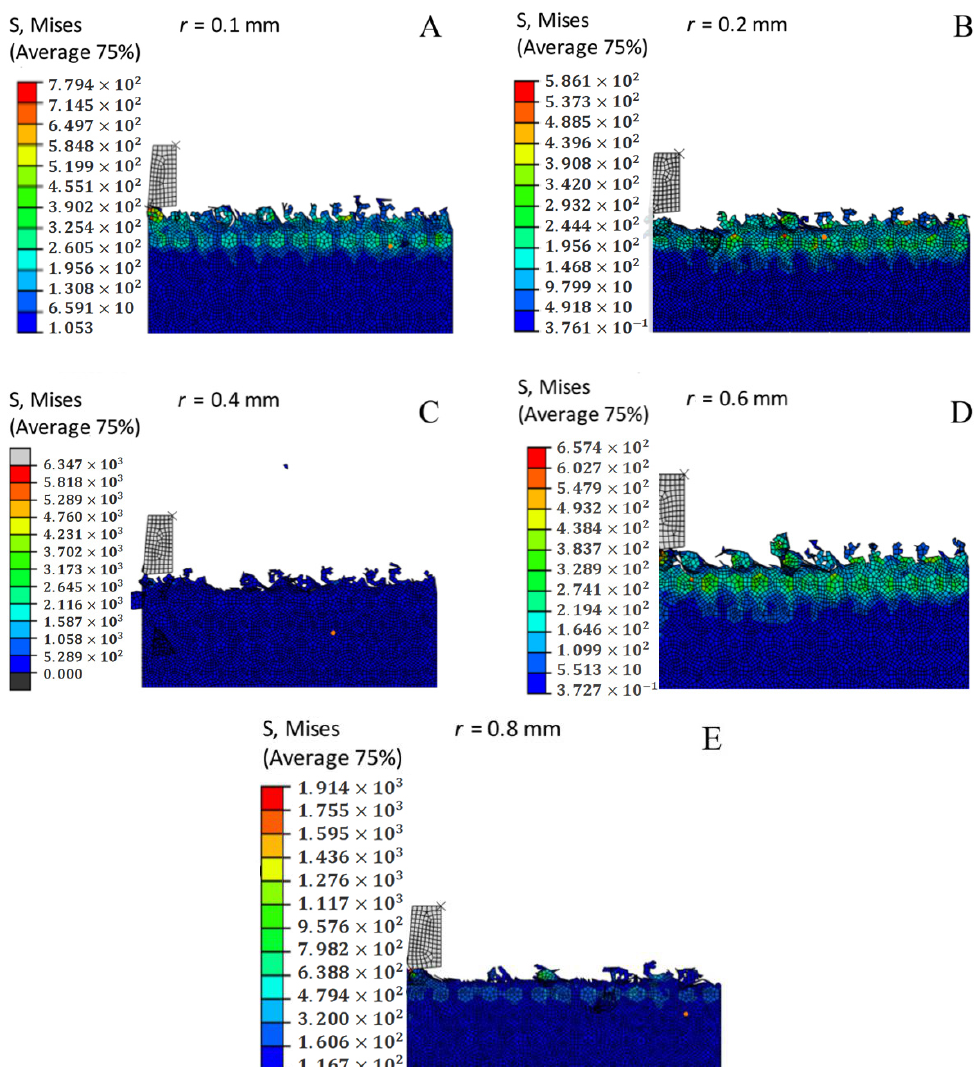
Figure 15. Chip morphology in milling with different corner radii. ( A ) r = 0.1 mm. ( B ) r = 0.2 mm. ( C ) r = 0.4 mm. ( D ) r = 0.6 mm. ( E ) r = 0.8 mm.